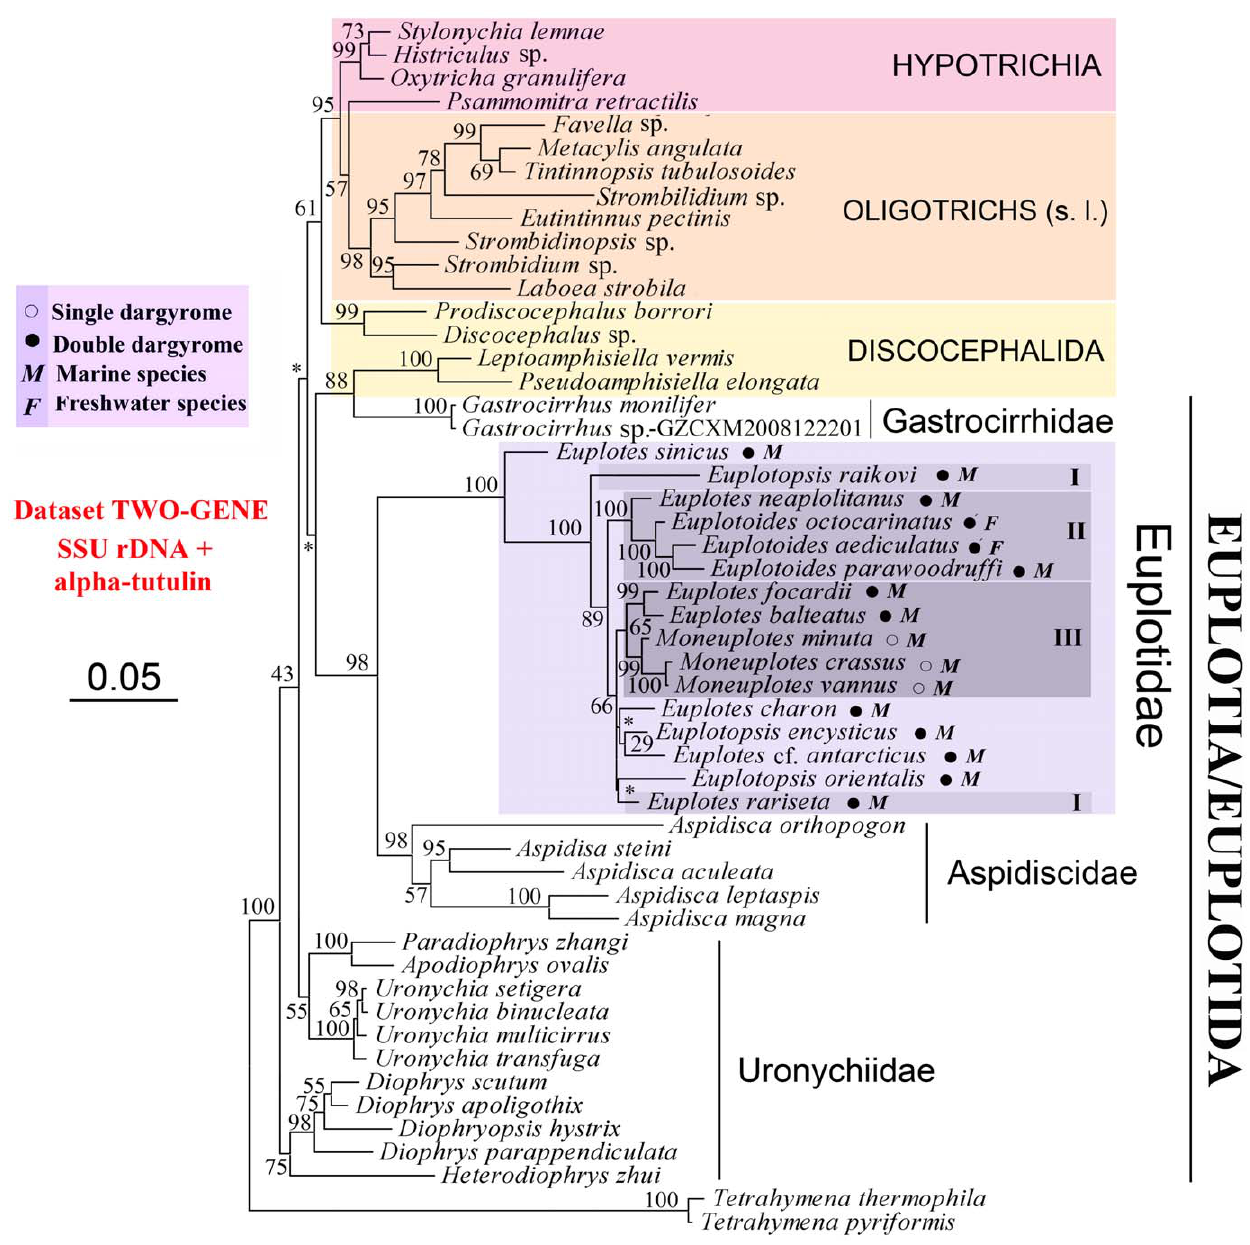
Figure 3. Best tree of the Spirotrichea inferred by two-gene combined sequences (Atub-SSU). Bootstrap values for branches of the ML tree is given on nodes. The scale bar corresponds to 5 substitutions per 100 nucleotide positions. Dargyrome patterns and natural habitats are given after species name of euplotids by symbols. Clades I-IV for euplotids were designated according to Petroni [42] and Yi et al. [38].